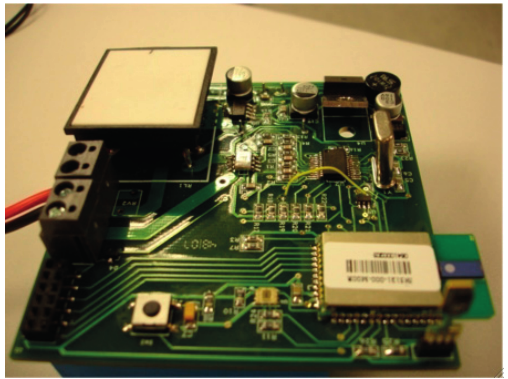
Figure 6. Additional sensor node. AC-voltage and current measurements.